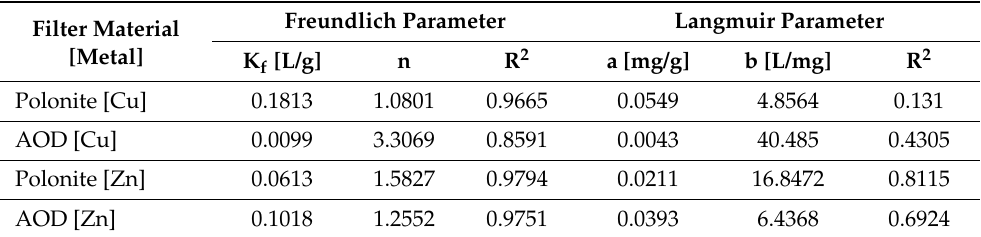
Table 2. Adsorption isotherm parameters obtained from the batch